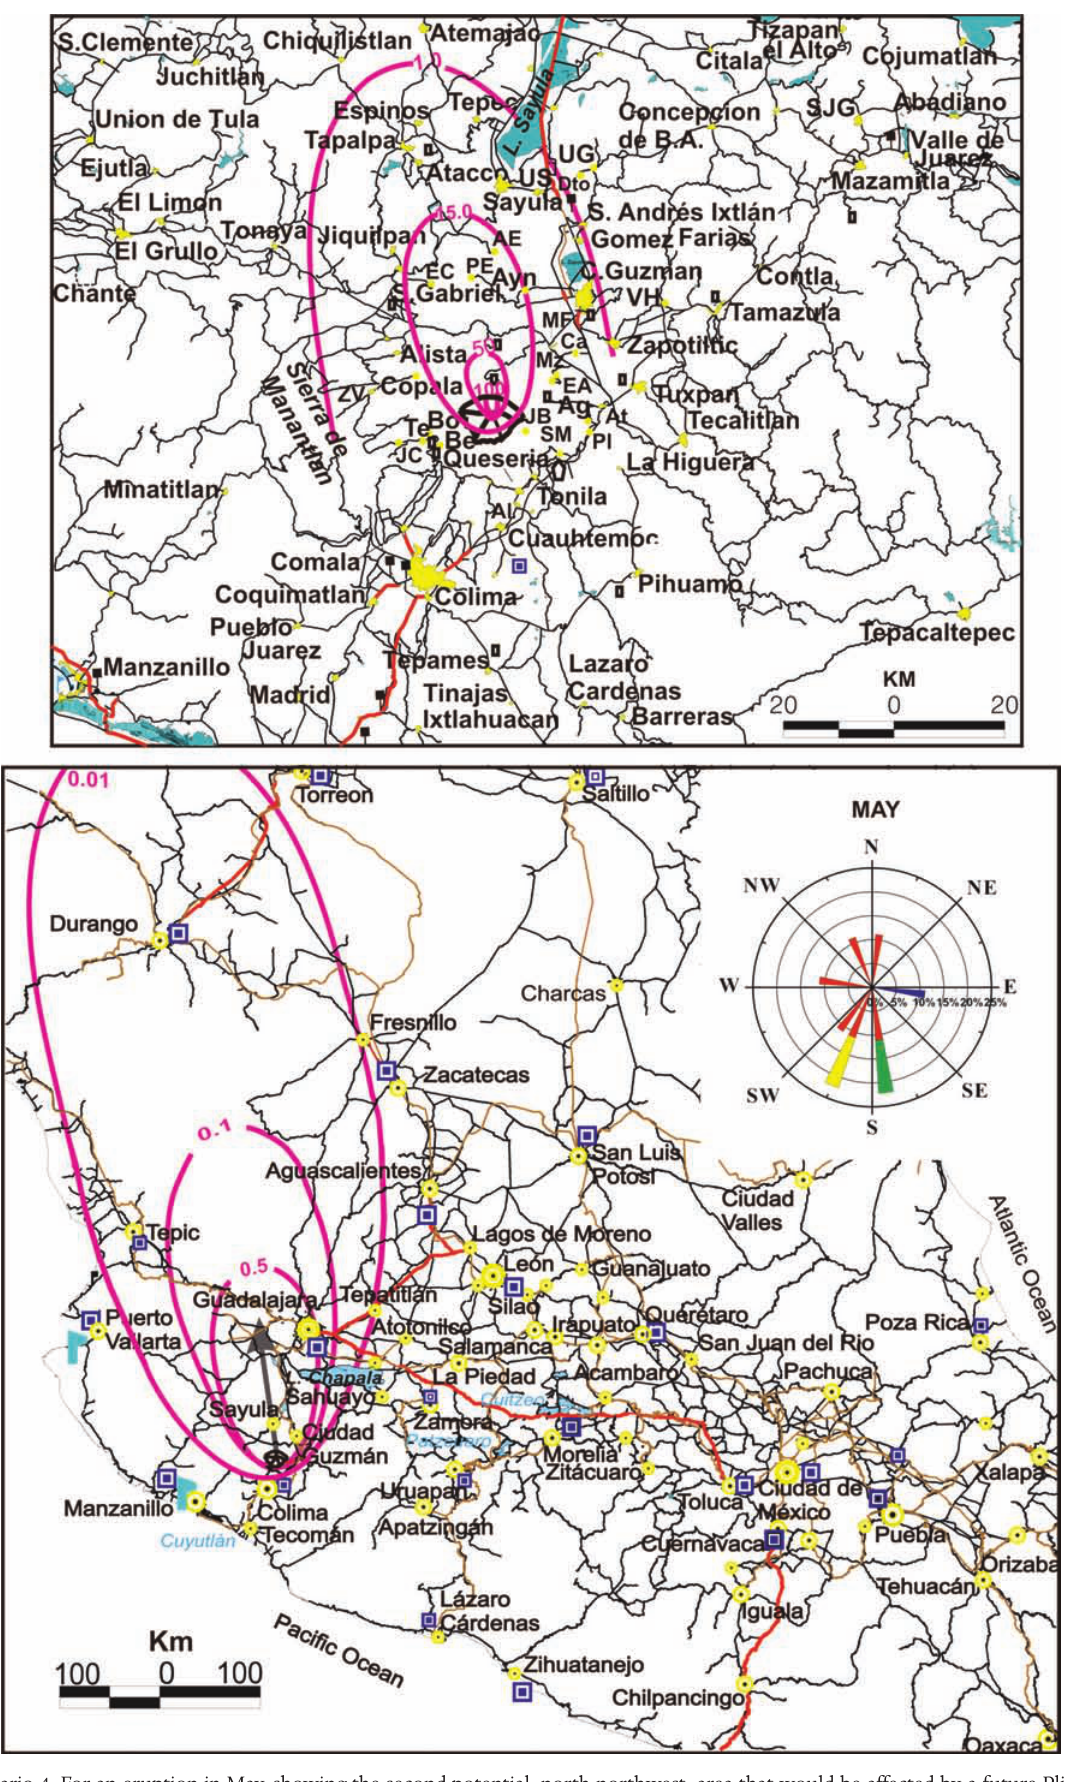
Figure 7. Scenario 4. For an eruption in May, showing the second potential, north-northwest, area that would be affected by a future Plinian eruption. For details, see legend to Figure